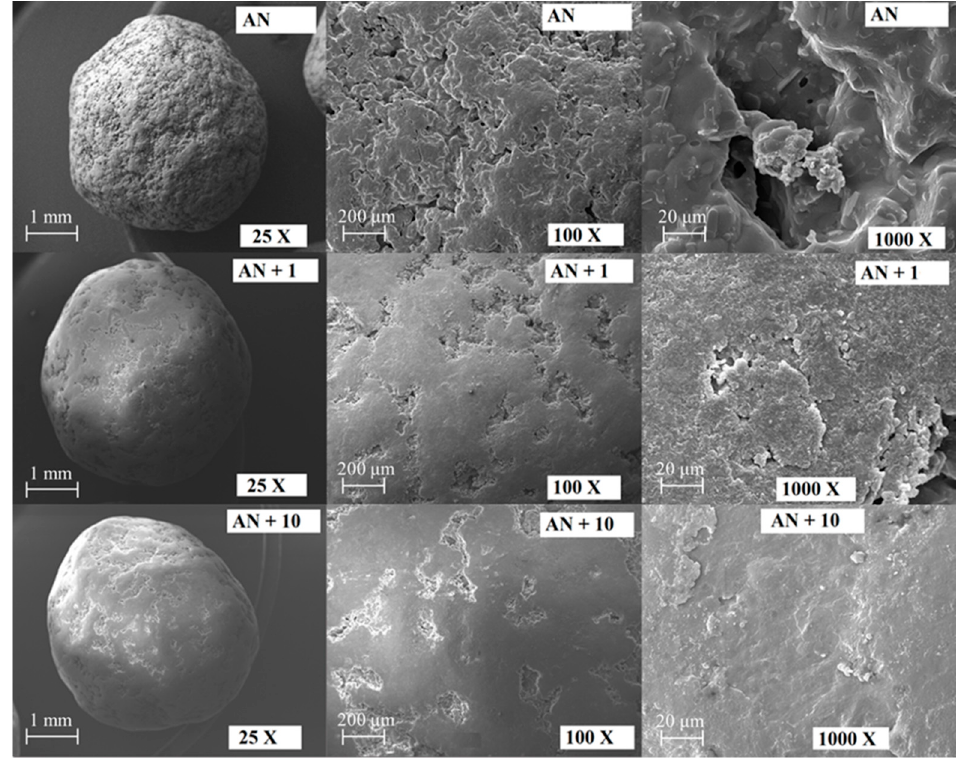
Figure 5. SEM images of uncoated AN fertilizer (AN) and AN fertilizers coated with 1 (AN + 1) and 10 (AN + 10) coatings. The image of each sample is shown at a magnification of ×25, ×100, and ×1000.